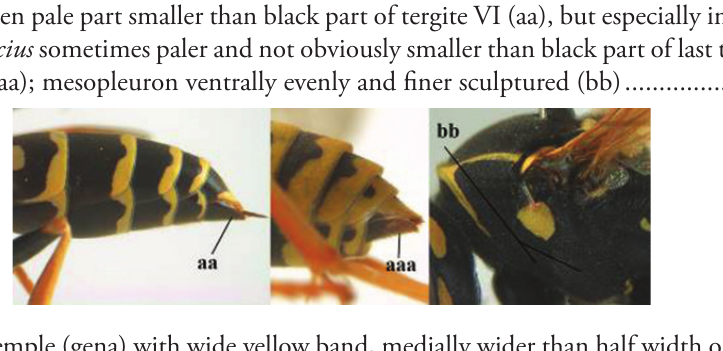
14 Temple (gena) with wide yellow band, medially wider than half width of tem- ple (a); clypeus yellow medially (b); propodeum and second tergite largely yellow (c); incision of eye mainly yellow (d); [frons slightly convex (about similar to area between antennal sockets and distinctly less so in P. dominula ) and mainly yellow, extent of yellow area variable, sometimes reaching